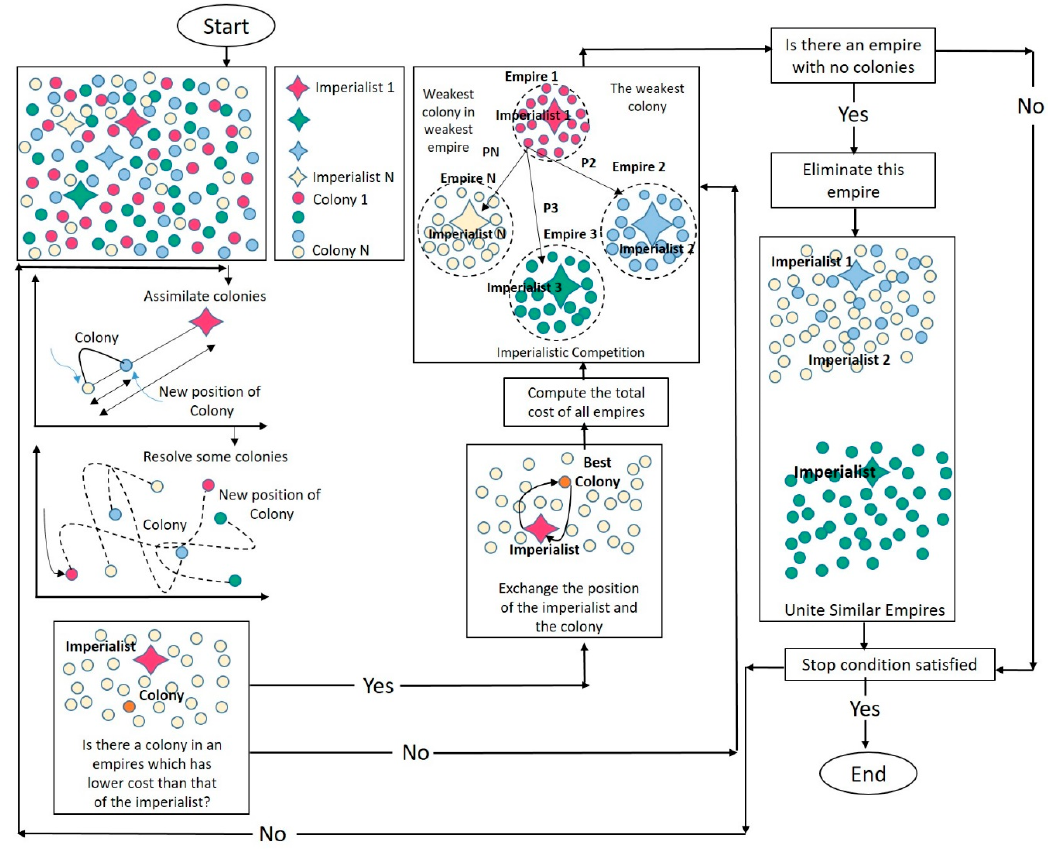
Figure 6. Flowchart of ICA modified from Atashpaz-Gargari amd Lucas [51].